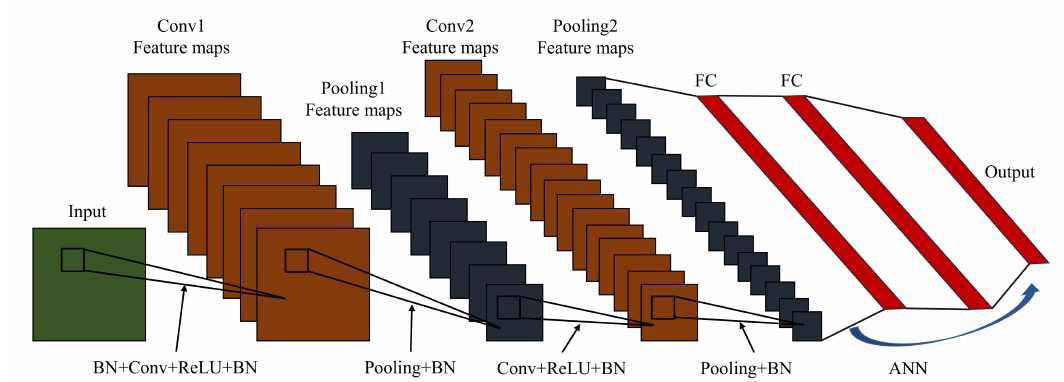
Figure 3. The classical structure of convolutional neural networks (CNNs). Batch normalization (BN) is a technique for accelerating network training by reducing the o ff set of internal